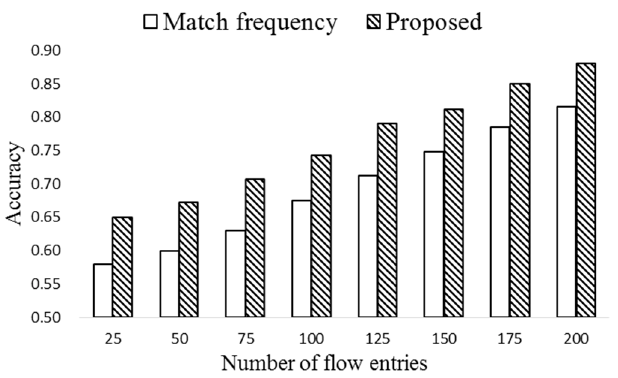
Figure 8. The comparison of prediction accuracies vs size of flow table.